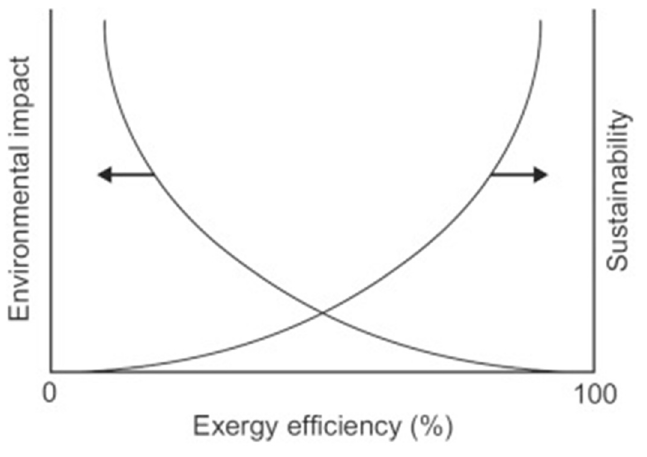
Figure 7. Intercourse between exergy efficiency, environmental impact, and sustainability of a thermal system. (Reprinted with permission from Ref. [177] with permission. Copyright © 2001 Elsevier.